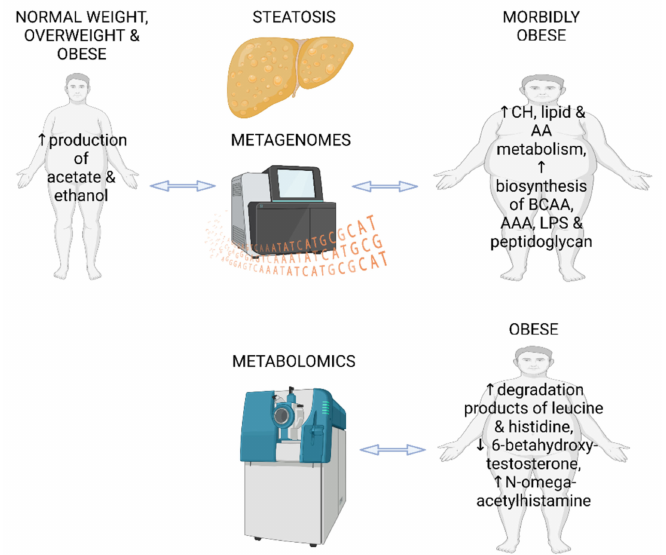
Figure 2. Main findings from two fecal metagenomic studies and one metabolomics study in individ- uals with hepatic steatosis and without diagnosed NAFLD. CH—carbohydrates; AA—amino acids; BCAA—branched chain amino acids; AAA—aromatic amino acids; LPS—lipopolysaccharides. The figure was created using